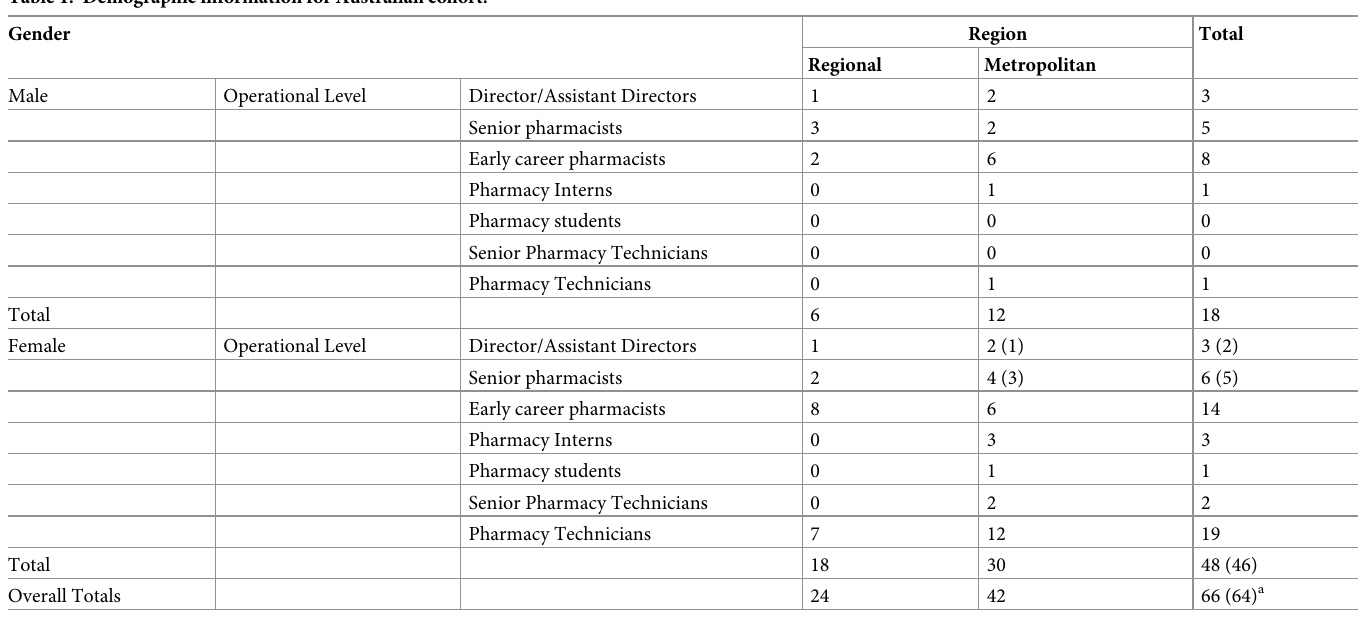
Table 1. Demographic information for Australian cohort.